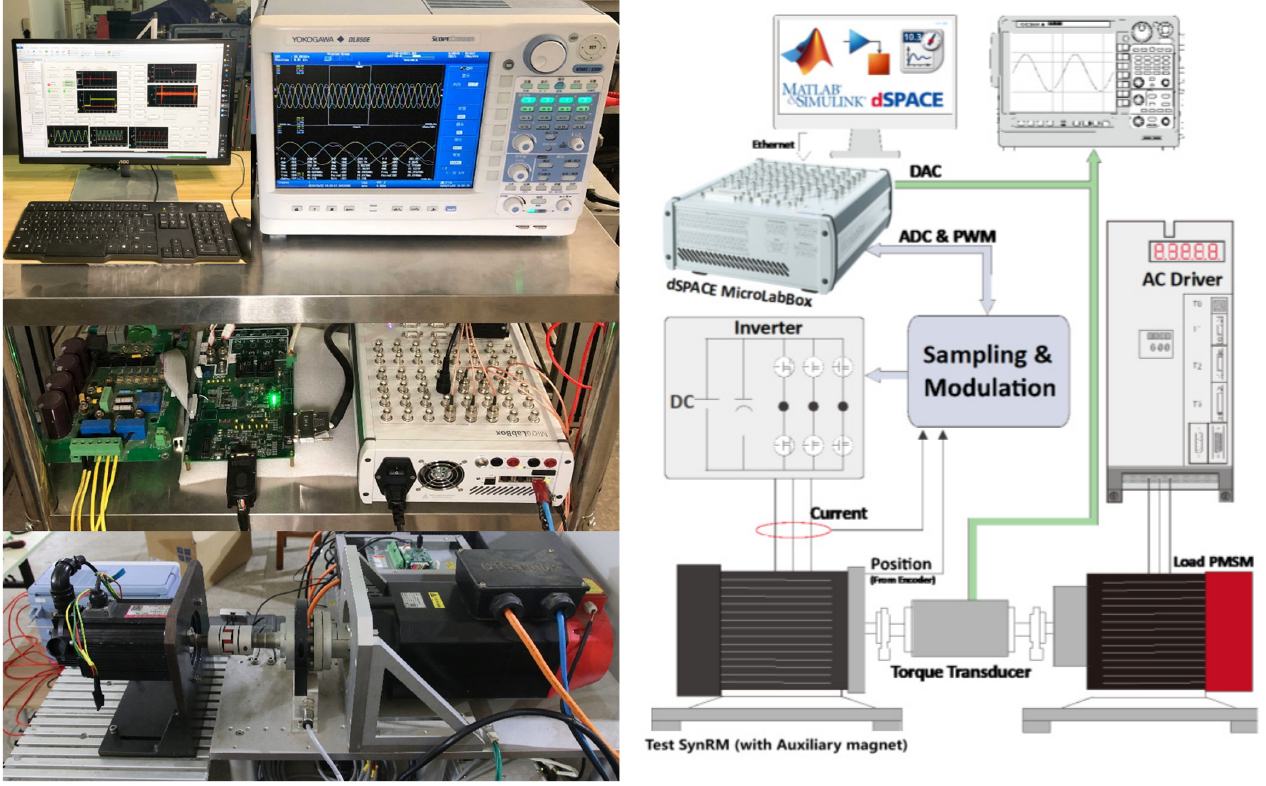
Figure 13. Experimental setup. Table 2. The parameters of the SynRM.